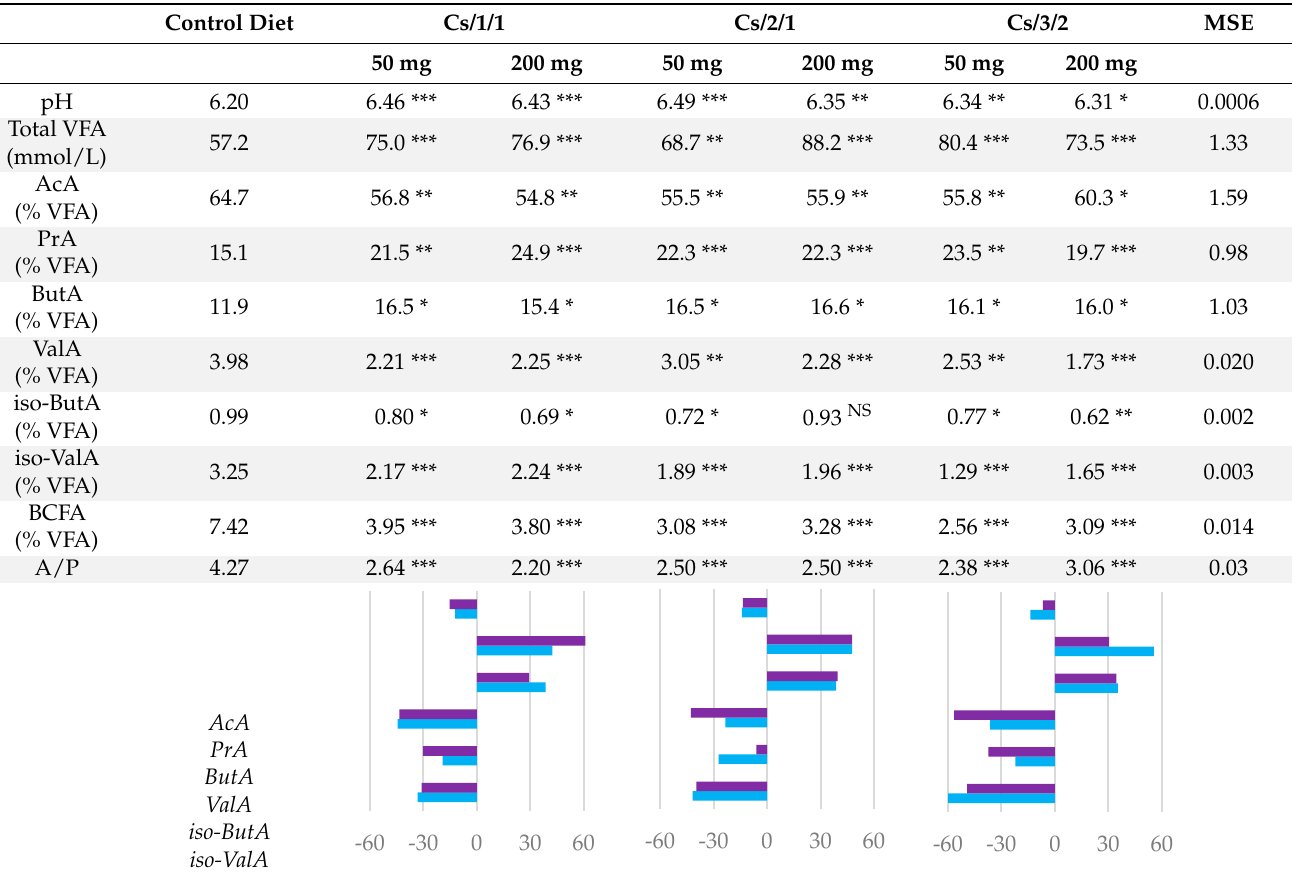
Table 7. Effects of C. sativa Cs/1/1 extract and its fractions Cs/2/1 and Cs/3/2 at 50-mg and 200-mg dose levels on fermentation end products after 120 h of incubation. Total VFA: total volatile fatty acids (acetate + propionate + butyrate + iso-butyrate + valerate + iso-valerate); AcA = acetic acid; PrA = propionic acid; ButA = Butyric acid; ValA = valeric acid; iso-ButA = iso-butyric acid; iso- ValA = iso-valeric acid; BCFA= branched chain fatty acids (iso-butyrate + iso-valerate/total VFAs); A/P = acetate/propionate. Along the row * p < 0.05, ** p < 0.01 and *** p < 0.001; NS: not significant; MSE: mean square error. In the lower panel, the percentage increase or decrease in each volatile fatty acid is plotted for different tested dose levels ( • 50 mg and • 200 mg) vs. FA% in the control